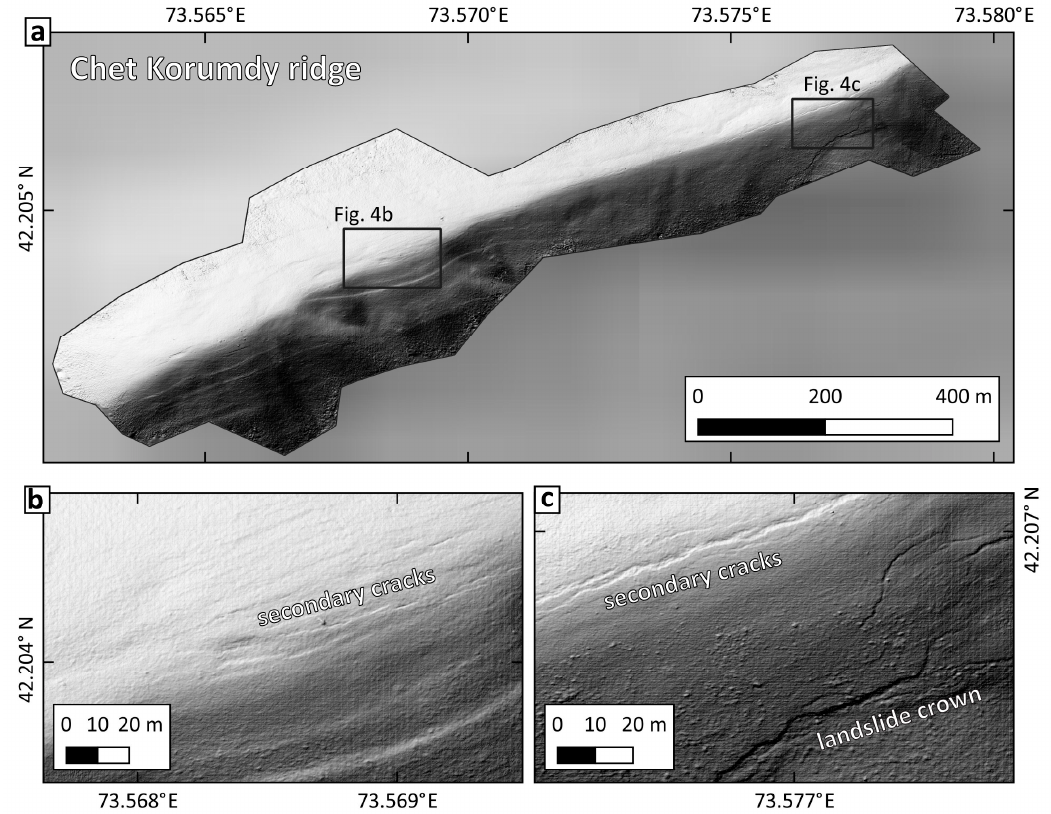
Figure 4. Secondary ruptures at Chet Korumdy ridge included small grabens that formed at the top of the ridge and mainly south-facing scarps on its southern side. ( a ) Overview of the western part of Chet Korumdy ridge. ( b )Detail of the small grabens and secondary cracks that formed on top of the ridge. Also see Figure 3d. ( c ) Secondary cracks on top of the ridge and south-facing crown of a landslide that formed in the 1992 earthquake. The hillshade is from drone survey imagery and has a resolution of 2.91 cm/pixel.